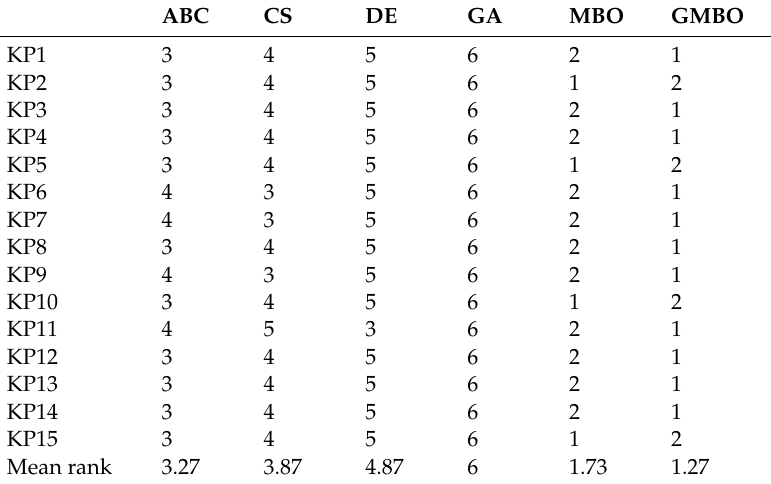
Table 13. Rankings of six algorithms based on the mean values.